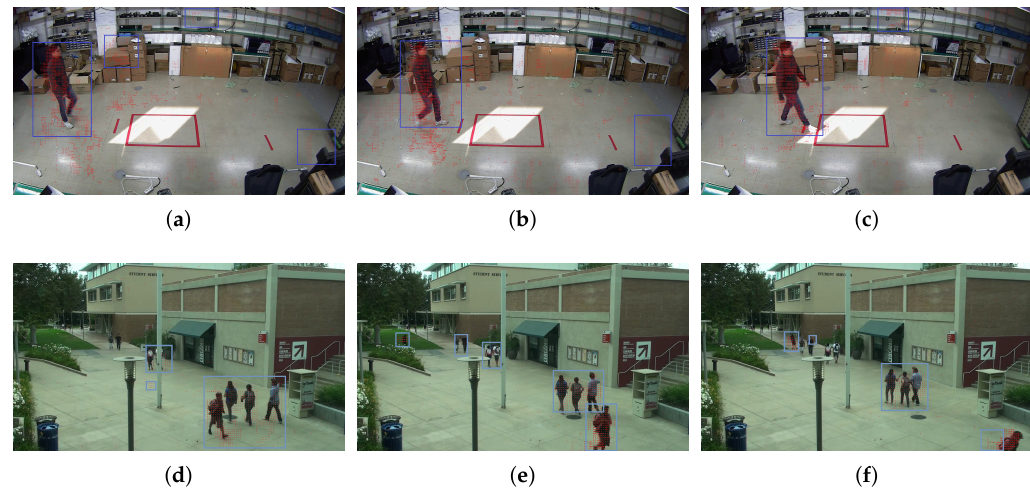
Figure 7. Video coding motion vector extraction from consecutive frames with two video test sequences. ( a – c ) our recorded video; ( d – f ) test video in